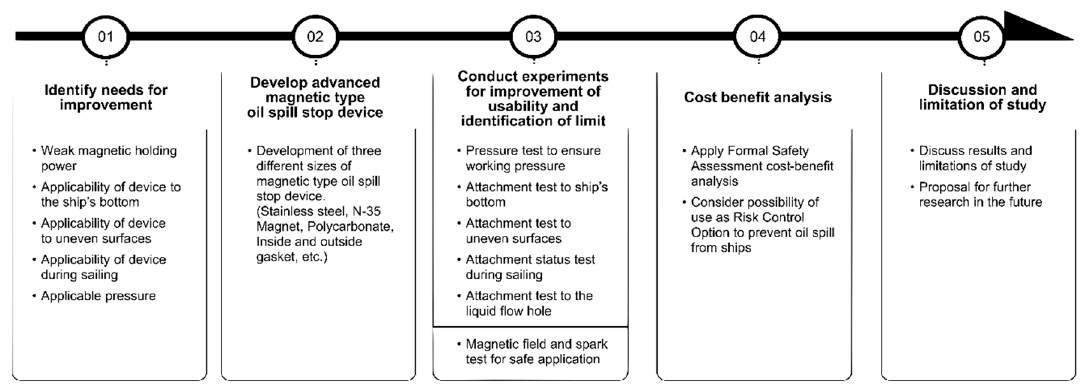
Figure 1. Method and procedure of this study.